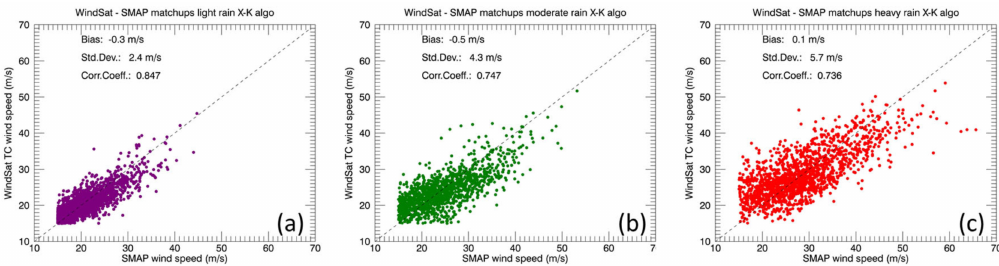
Figure 12. Same as in Figure 4 but using the WindSat X-K-band TC-wind